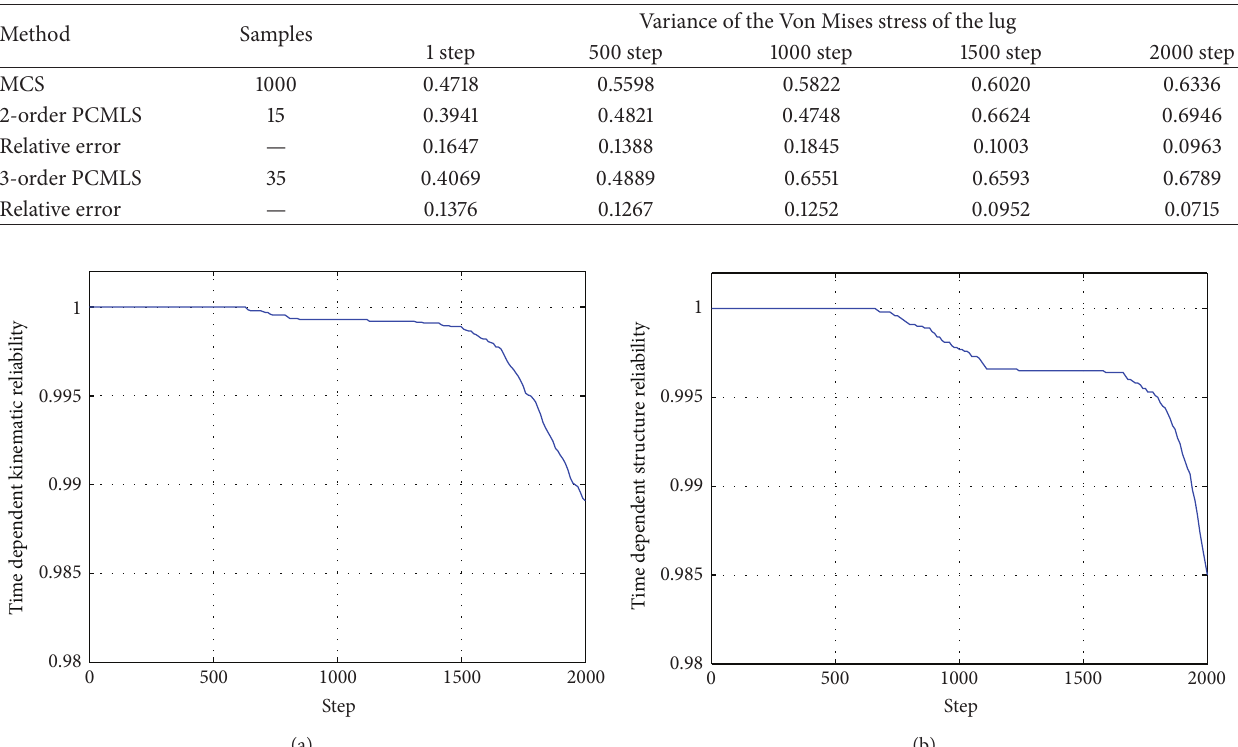
Table 6: Comparative results of the variance of the Von Mises stress of the lug along the time axis.